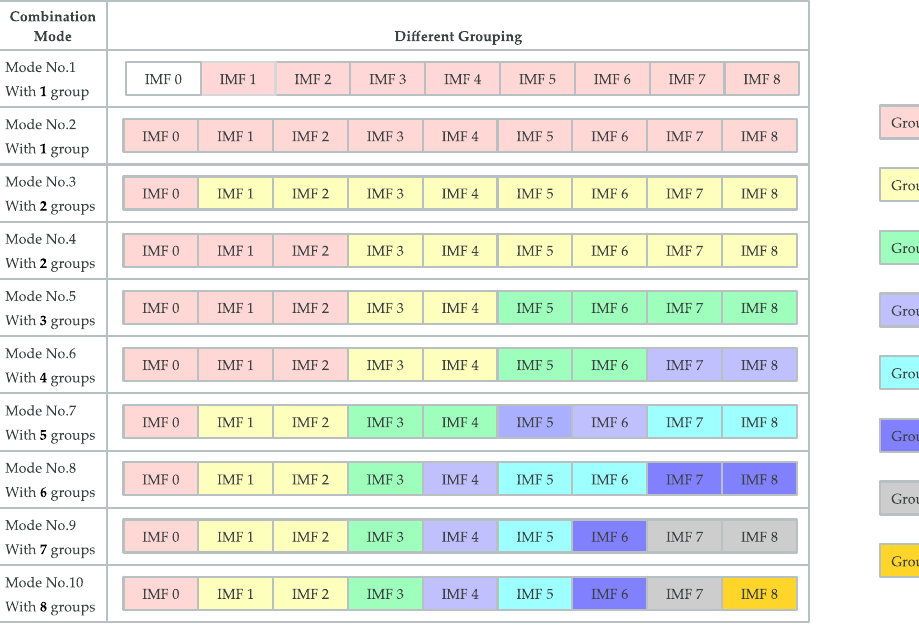
Figure 10. Different modes with different groups shown by different color blocks. Table 3. Comparison of RMSEs of prediction results with different groupings.